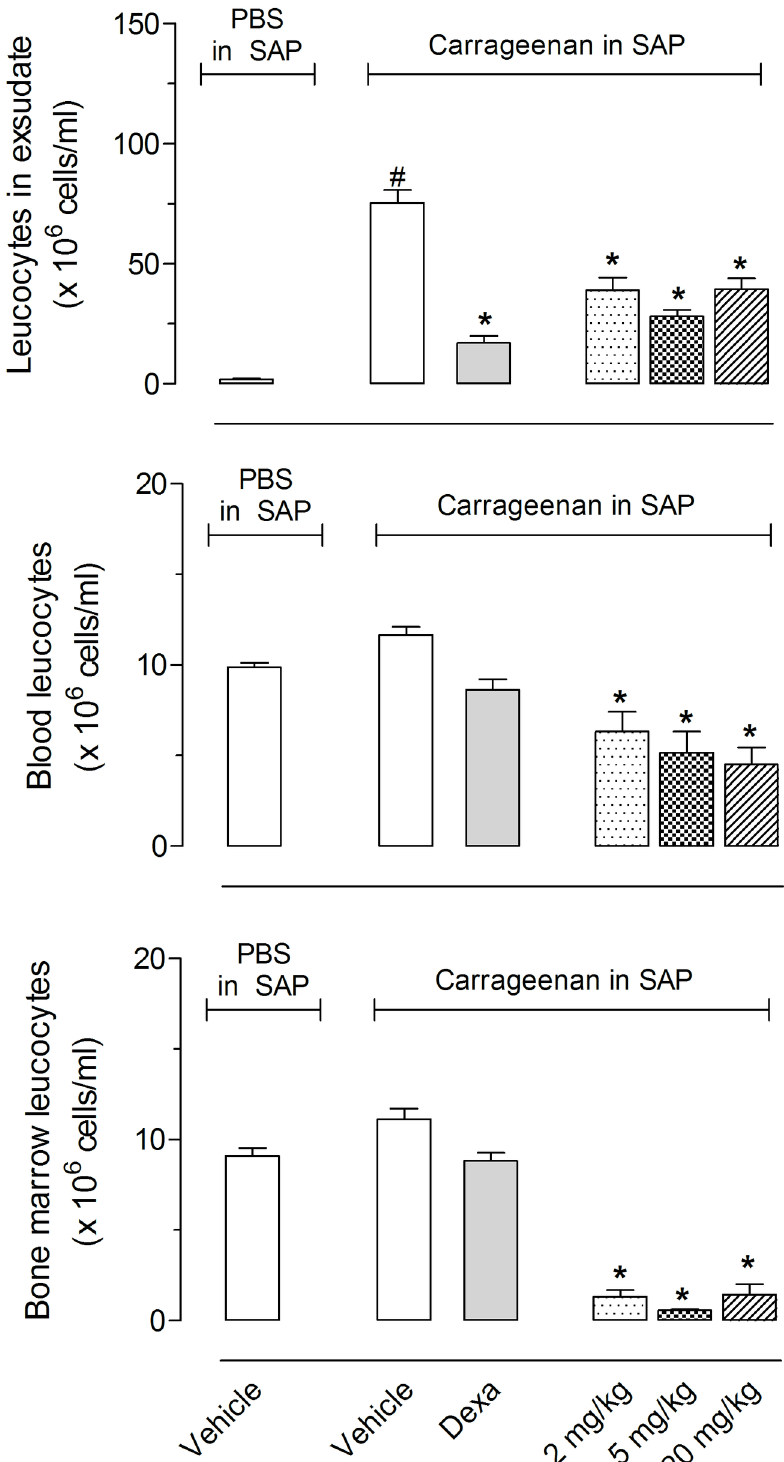
Fig 6. Effects of pure citral on total leukocyte counts in blood and bone marrow. Animals were pretreated with citral (2, 5 or 20 mg/kg) or vehicle 1 h prior to carrageenan (1%) injection into the SAP. The results are presented as the mean ± S.D. (n = 10 per group) of leukocytes (x 10 6 /mL) in ex udate, blood or bone marrow. Statistical significance was calculated by ANOVA followed by Bonferroni's test. * P <